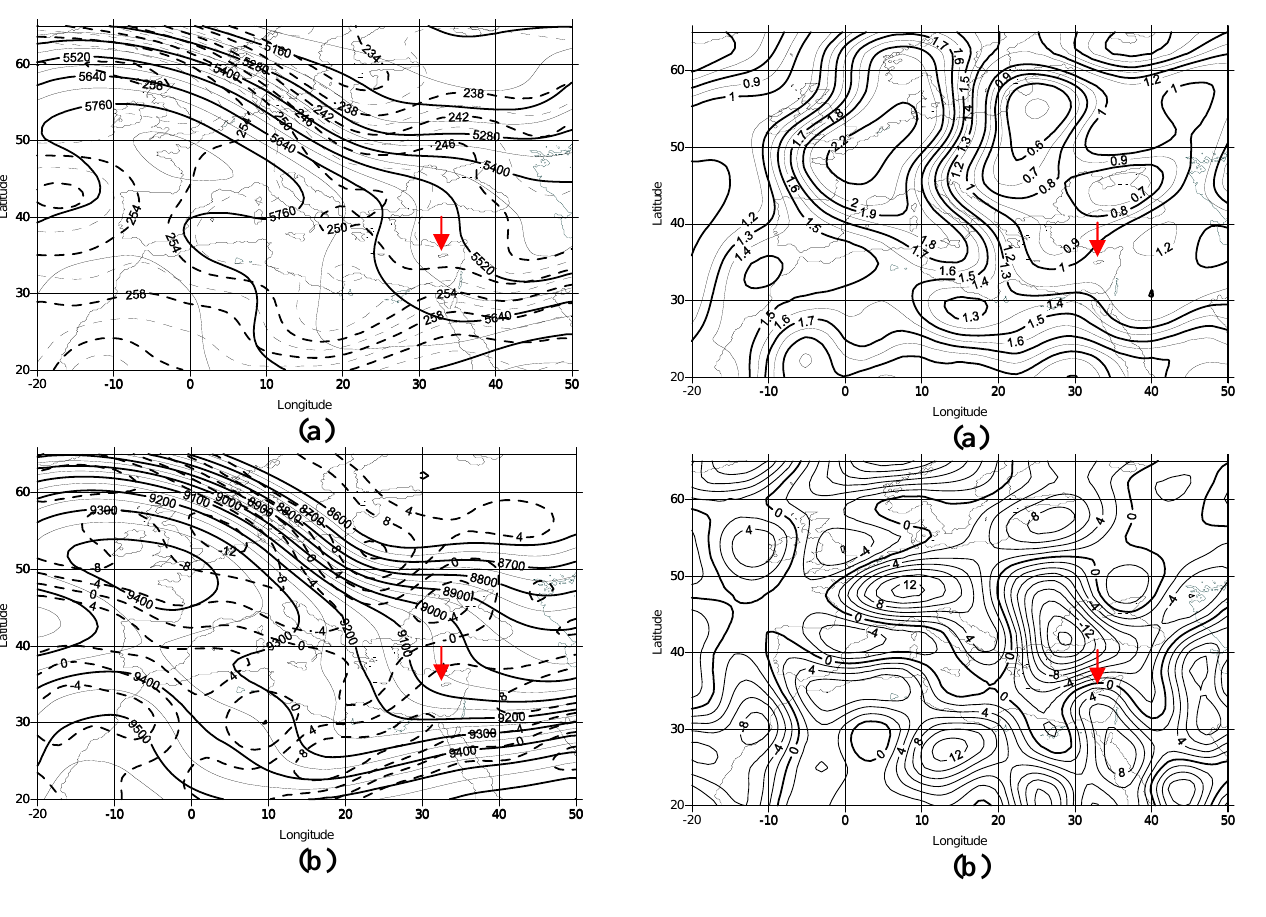
Fig. 5. As Fig. 3, but for 00:00UTC 28 January 2008. upper tropospheric divergence (300 hPa divergence) over the same area (calculated but not presented) denotes enhanced ascending motion and cloud formation. The infra-red satel- lite image of Fig. 8 displays the extensive cloud formations covering the eastern Mediterranean area corresponding to this time. At this time, the trough extended further southwards, reaching the area of Cyprus, with its axis just to the west of the island (see Fig. 9). From the shape of the trough, it can be suggested that the trough tends to become cut-off from the general circulation; nevertheless, its sharp curvature still provides adequate cyclonic vorticity for intense weather phe- nomena to continue to occur. At 300 hPa, the jet had split into two parts: one ahead and the other behind the upper trough’s axis (see Fig. 9) The geopotential height at 500 hPa over Cyprus has decreased by 150 gpm in a 48 h period, low- ered to 5400 gpm. At the 300 hPa isobaric level, enhanced cyclonic circulation over the area of interest was observed, due to the positive values of the relative vorticity field over the study region; the spot value over Cyprus was at this time 8 × 10 − 5 s − 1 , supporting further cyclonic development.